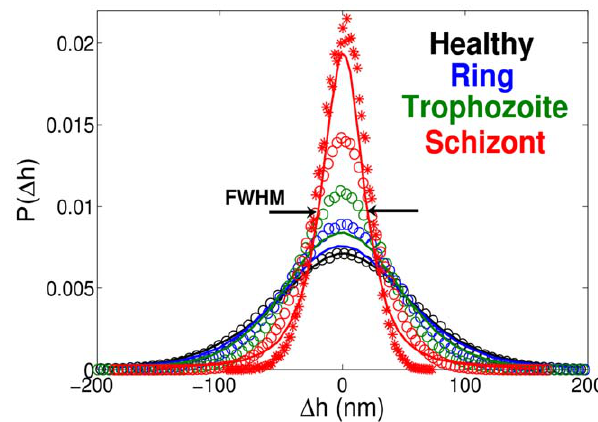
Figure 5. Membrane fluctuation distributions at different stages of Pf-RBCs monitored at room temperature T ~ 23 o C . The experimental data [4] are drawn with solid lines, simulations employing the biconcave RBC shape are plotted with circles, and a simulation with a nearly spherical shape is shown by ‘‘*’’. FWHM identifies the full-width half-maximum value of the distribution curves. The shear moduli of Pf-RBCs for different stages are given in Table 1. The bending stiffness and the membrane viscosity in all cases are set to 2 : 4 | 10 { 19 J and 0 : 022 Pa : s , respectively. doi:10.1371/journal.pcbi.1002270.g005 several experimental results on lipid vesicles [25,26] show a slight decrease in bending rigidity with increasing temperature. However, as we increase temperature to the febrile value, the discrepancy between simulations (blue squares) and experiments (black circles) for healthy RBCs becomes more pronounced. This difference can be reconciled by an effective bending rigidity to be four times lower (red triangles) than k c ~ 2 : 4 | 10 { 19 J at room temperature, however such a sudden decrease in bending rigidity is not likely to occur.